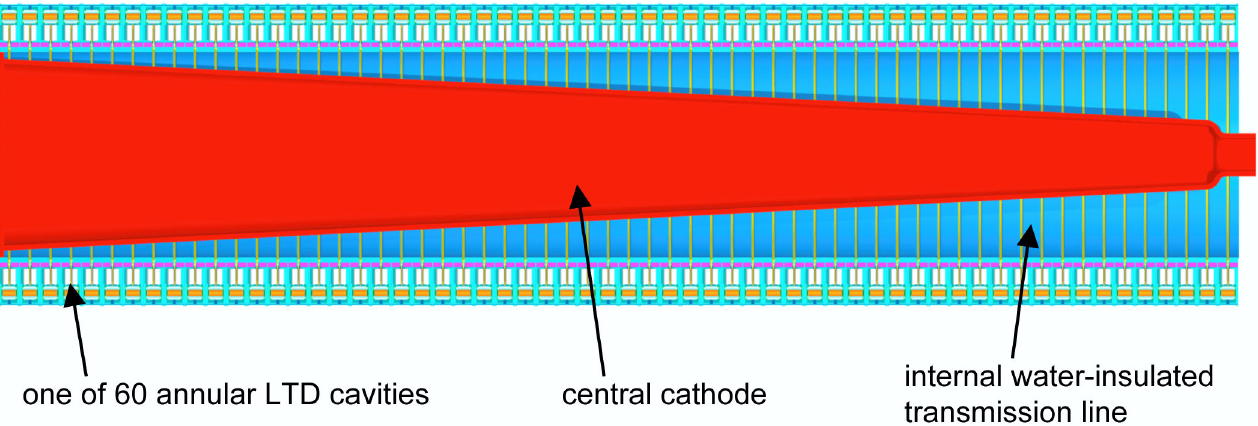
FIG. 2. (Color) Cross-sectional view of a single 60-cavity LTD module. A total of 210 such modules would drive the accelerator illustrated by Fig. 1. The outer diameter of the module is 3 m.